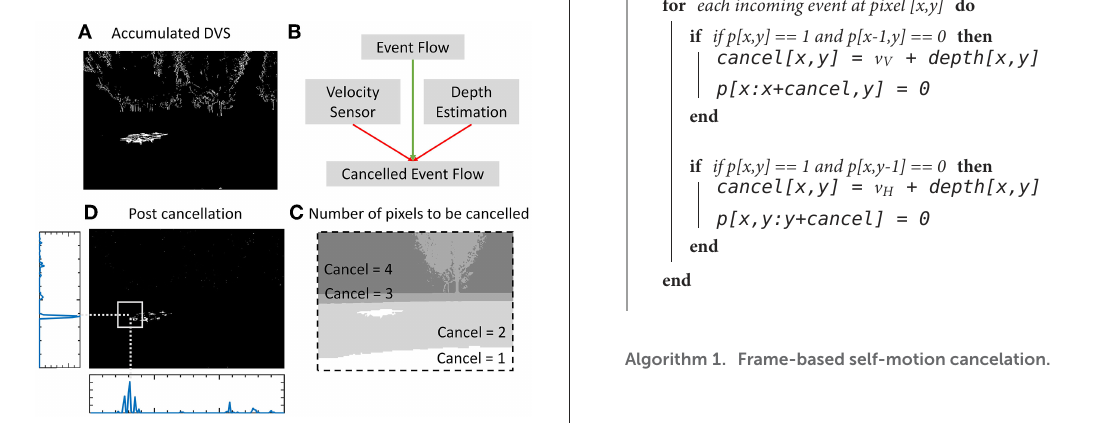
FIGURE2 (A) Accumulated events within a time window from the event camera. (B) High self-velocity and higher depth requires more activity cancelation to preserve the activity of the moving target in close vicinity. (C) Number of pixels to be canceled at every position in the image. (D) Ego-motion cancelation removing the activity corresponding to the stationary objects with the surviving activity corresponding to the target (prey drone).